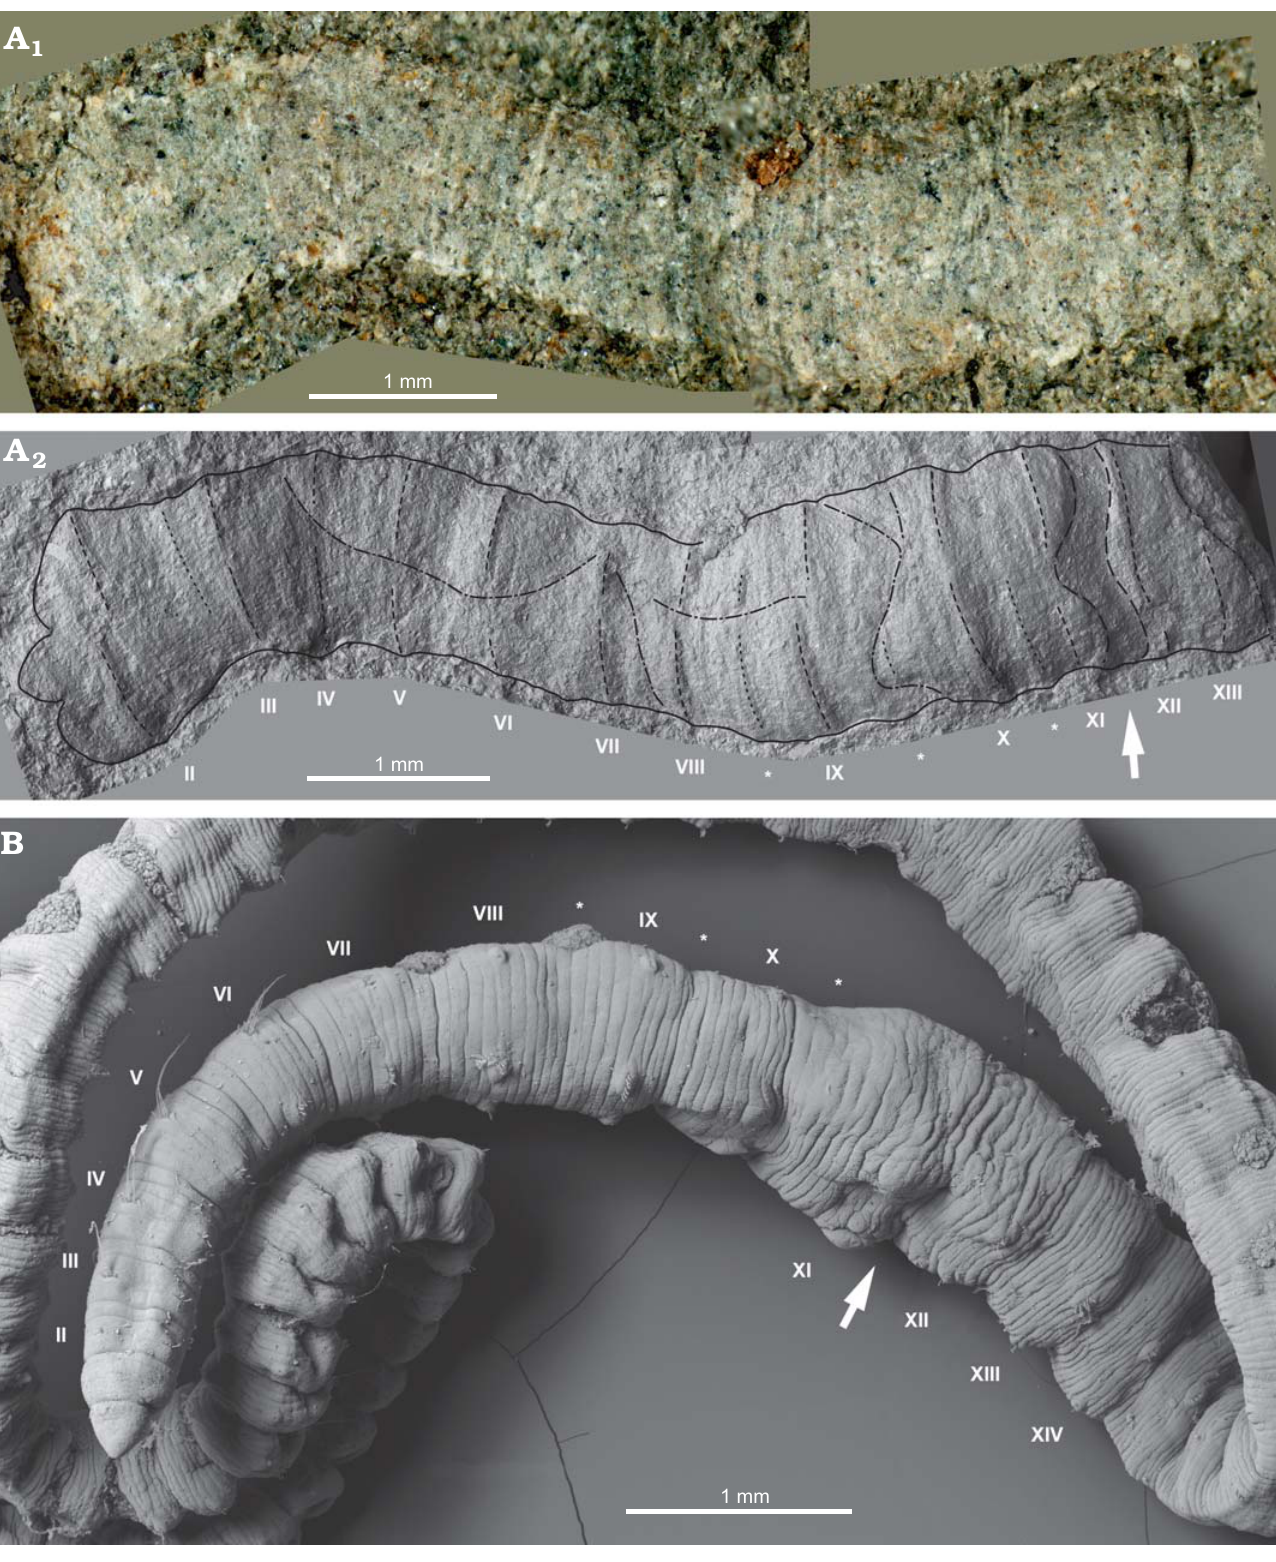
Fig. 2. Microdrile oligochaete PIN 5640/212 ( A ) from Petropavlovka Formation, Olenekian (Lower Triassic), Petropavlovka III section, Russia and extant Tubifex tubifex (Müller, 1774) ( B ) from Khripan’ River, Moscow region, Russia. A . Photograph under polarised light (A 1 ) and SEM image depicting main features of the specimen ( А 2 ): general outlines (continuous line), W-shaped depression (long dashed line), prominent annuli (dashed line), dissepiments (dotted line), and post-mortem fractures (dash-and-dot line). B . SEM image. Dissepiments (asterisks), segments are numbered, depression in posterior part of genital region